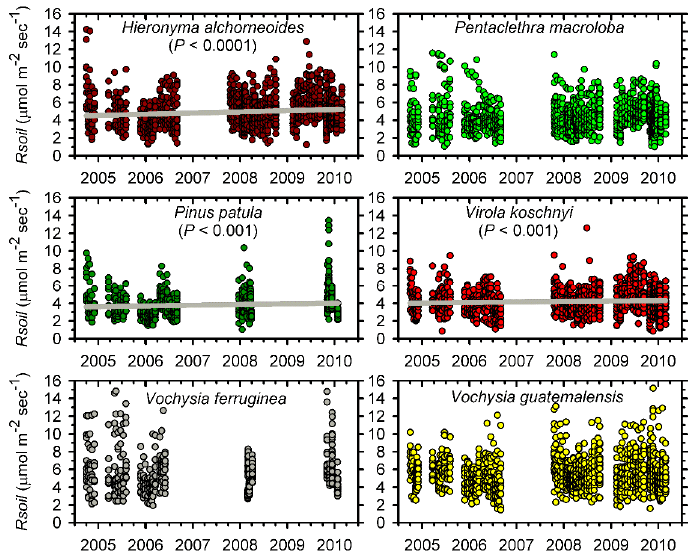
Figure 4. From late 2004 to early 2010, soil respiration ( Rsoil ) increased significantly in plantations of Hieronyma , Pinus and Virola , but not in other plantation types. Lines show the least ‐ square regressions of significant relationships; among those three species the rate of increase averaged 0.09 µ mol · m − 2 · s − 1 · year − 1